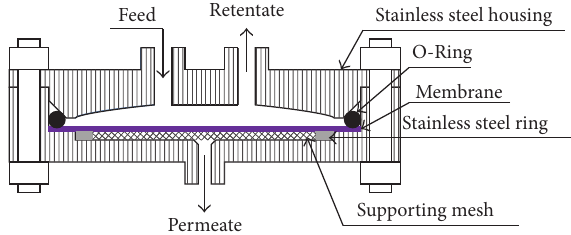
Figure 2: Components of the permeation module.